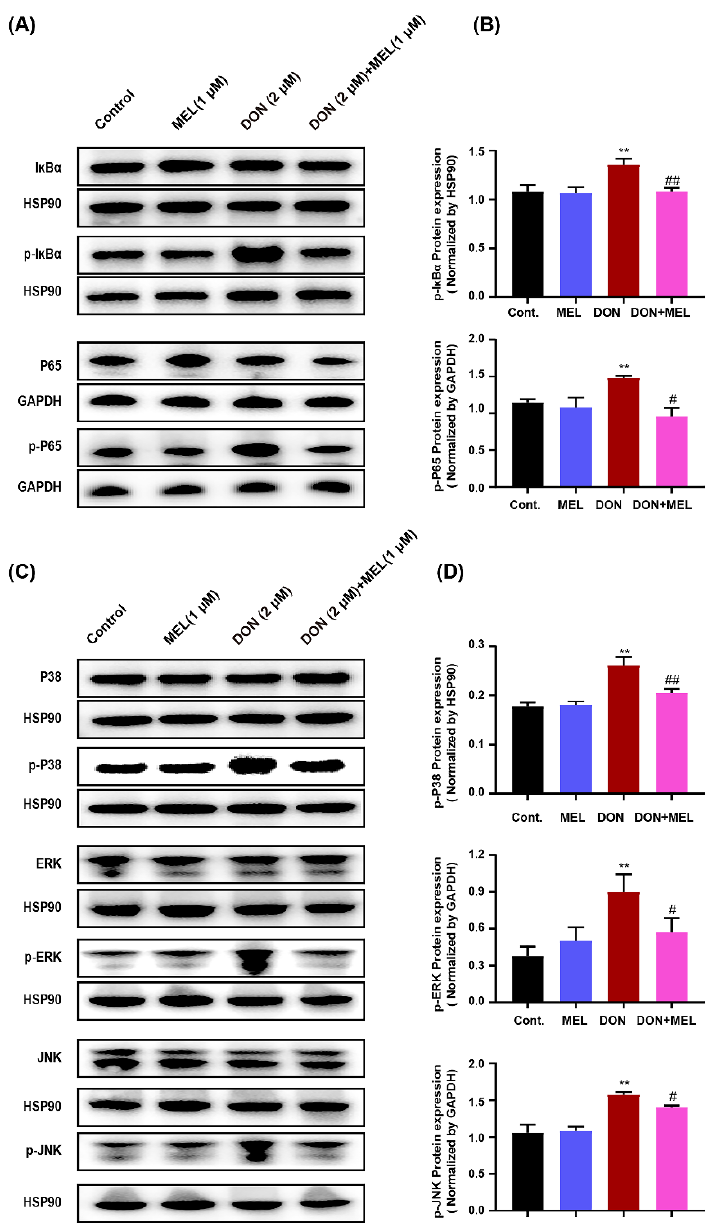
Figure 6. Melatonin (MEL) inhibits DON-induced NF- κ B and MAPK activation in murine ovary granulosa cells. Ovarian GCs were stimulated with DON, MEL, and DON+MEL for 24 h. ( A , B ) IkB α (1:1000 dilution), p-I κ B α (1:1000 dilution), P65 (1:1000 dilution), and p-P65 (1:1000 dilution) were examined using western blotting in GCs treated with DON, MEL, and DON+MEL for 24 h. ( C , D ) P38 (1:1000 dilution), p-P38 (1:1000 dilution), ERK (1:1000 dilution), p-ERK (1:1000 dilution), JNK (1:1000 dilution), and p-JNK (1:1000 dilution) were examined by western blotting in GCs. All data are shown as mean ± SD, n = 3. ** p < 0.05 compared with the control and MEL groups; # p < 0.05 and ## p < 0.05 compared with the DON group. MEL: